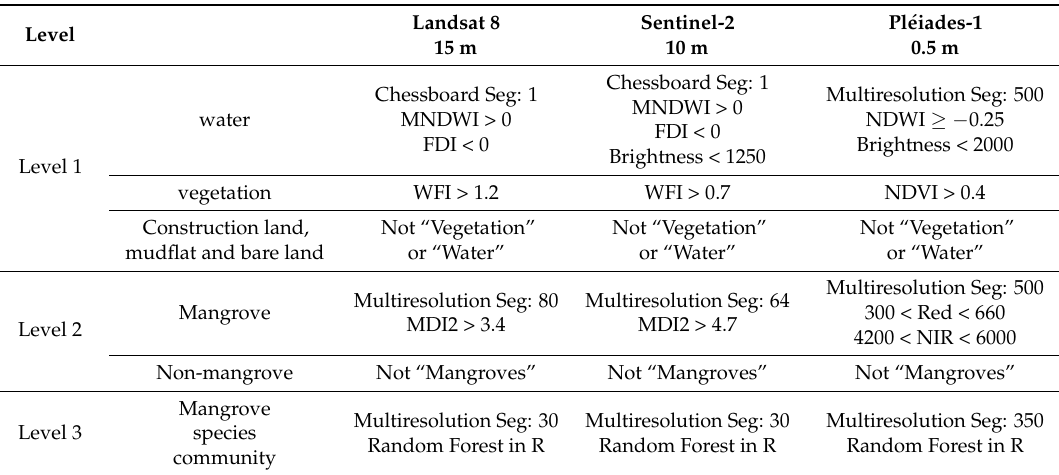
Not “Vegetation” or “Water”